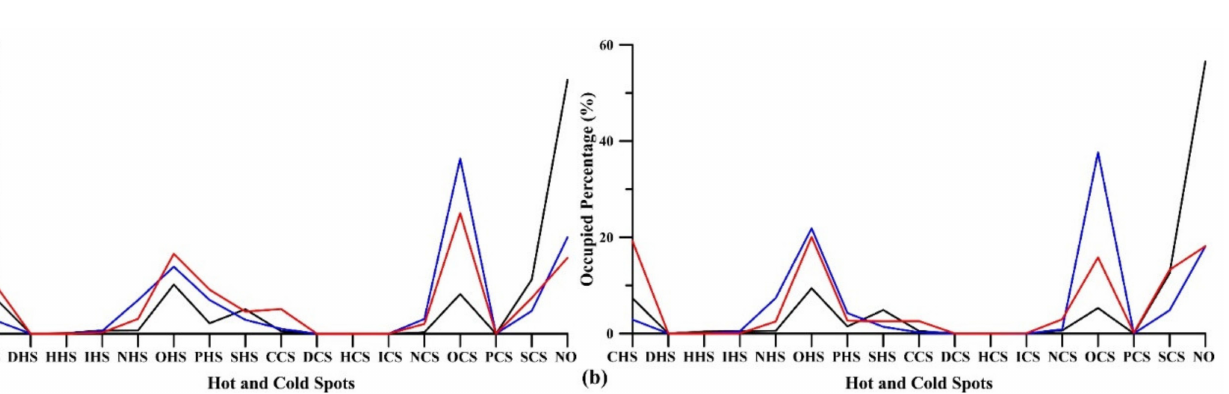
Figure 10. The occupied percentage of landslide hot spots and cold spots from 2005 to 2015 (black line), from 2005 to 2008 (blue line), from 2010 to 2015 (red line), and in the ARW ( a ) and TRW ( b